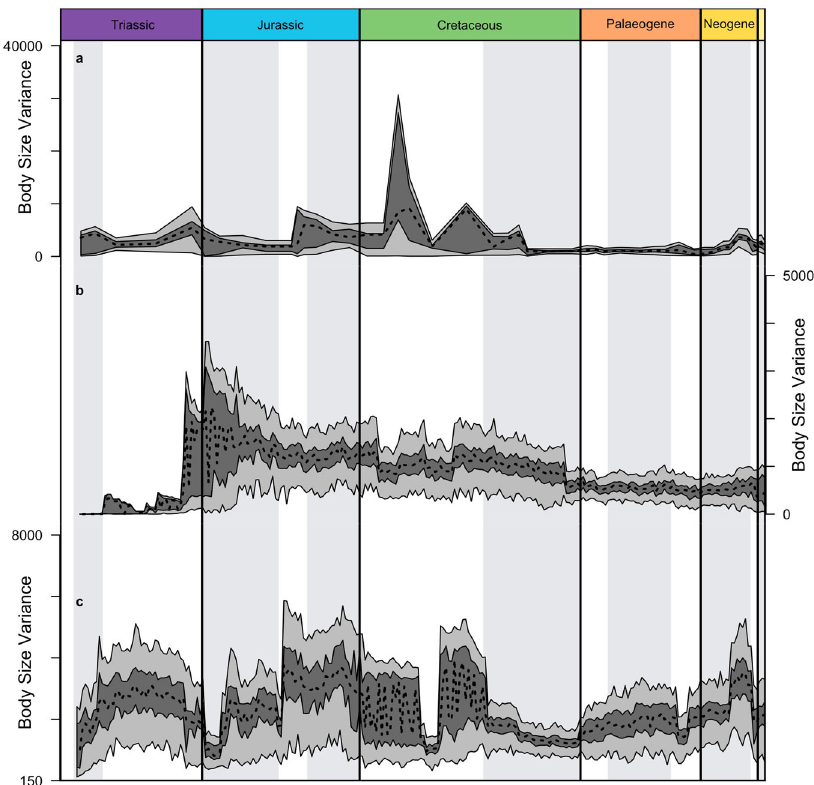
Fig. 3 Time-series representations of relative body size variance. Three approaches are shown, as in Fig. 4: ( a ) actual taxa binned at the resolution of stratigraphic stages; ( b ) actual taxa plus ghost ranges inferred using branch lengths; ( c ) actual taxa plus ghost ranges plus phylogenetically reconstructed body size values of inferred common ancestors. The taxa sampled across all methods were subjected to bootstrapping; the interquartile range is shown in dark grey, the total range in light grey.